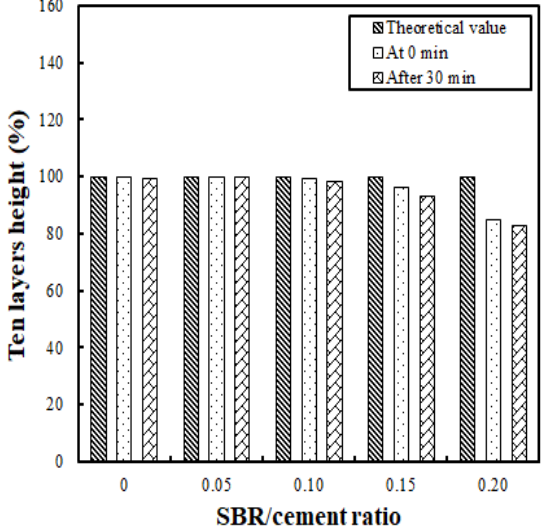
Figure 8. Comparison of buildability levels for different SBR/cement ratios.